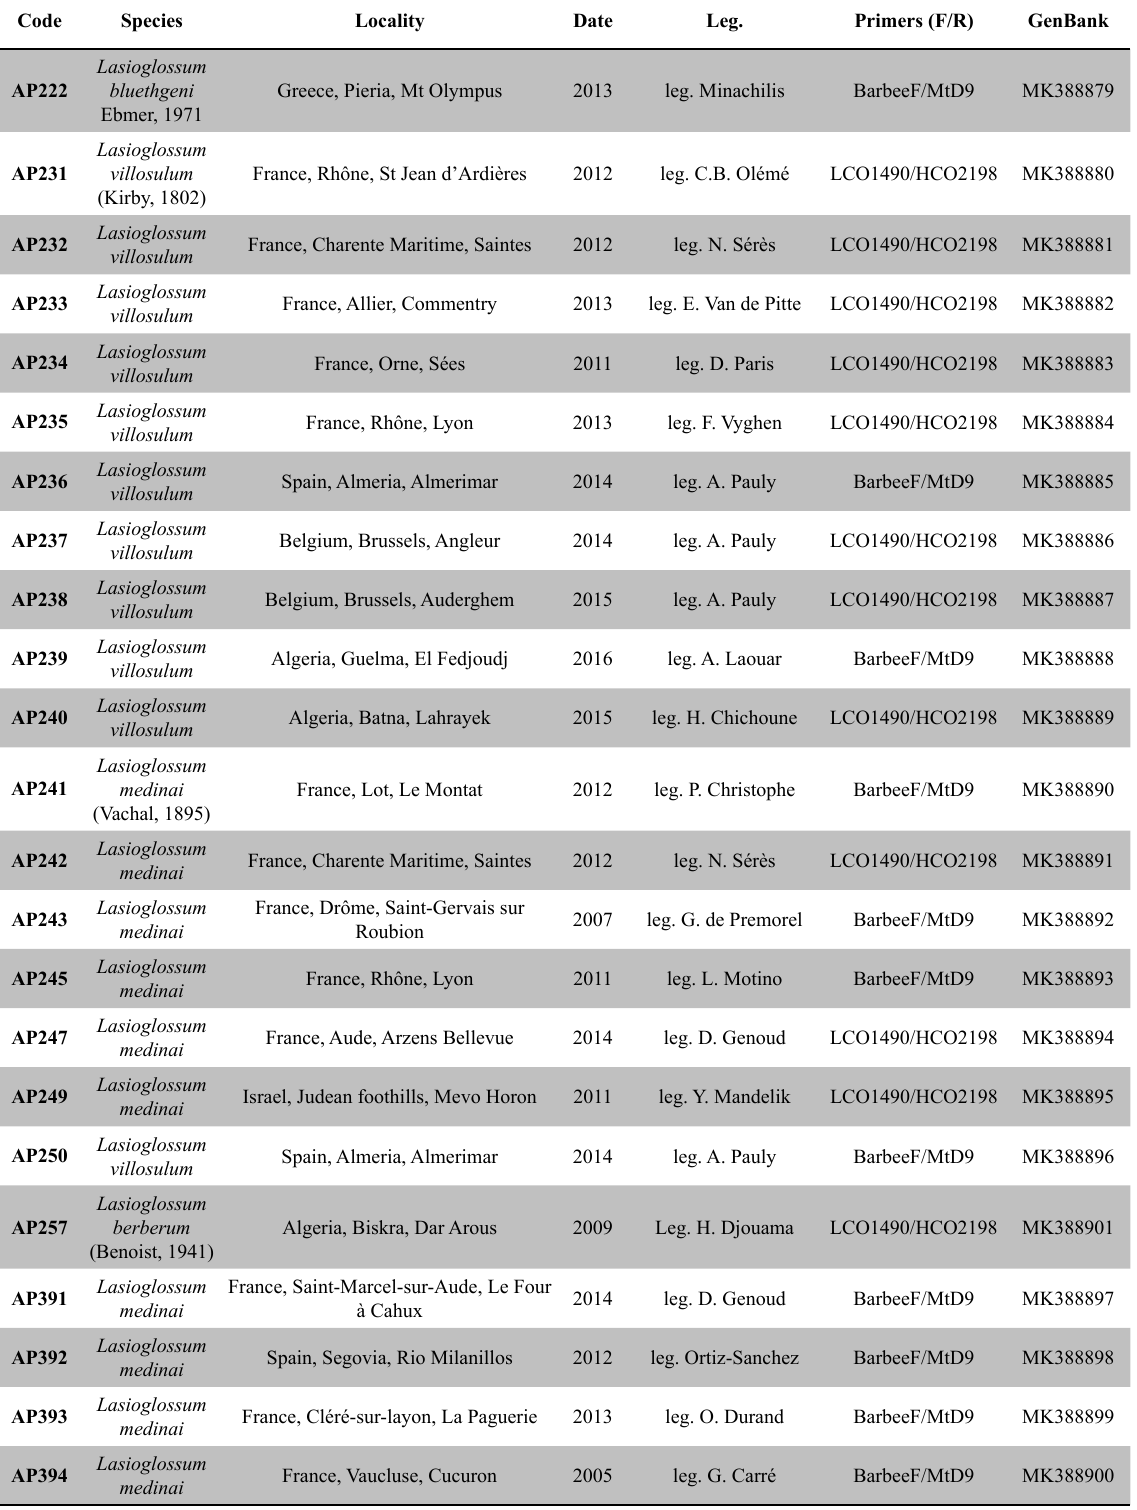
Table 1. Information of sequenced specimens used in the